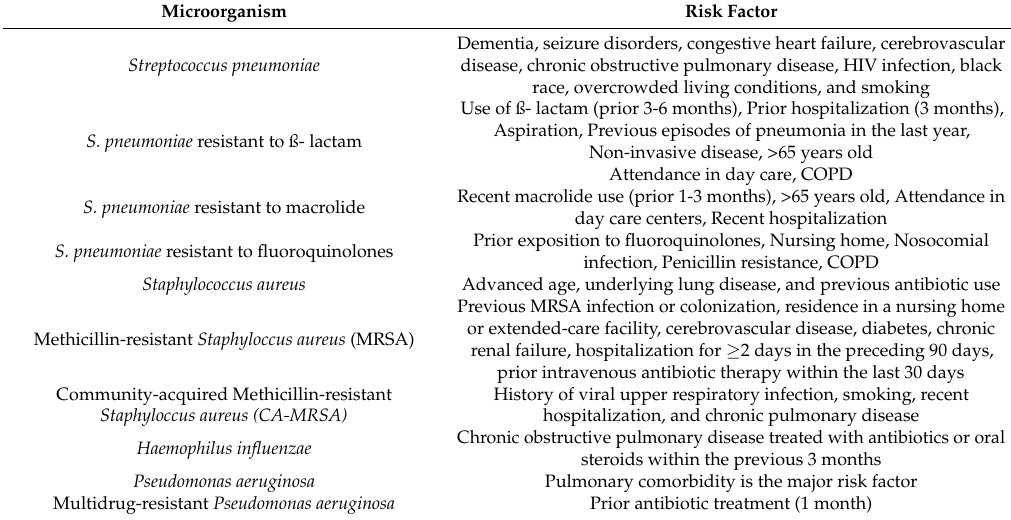
Table 2. Risk factors for specific microorganisms in Community-Acquired Pneumonia